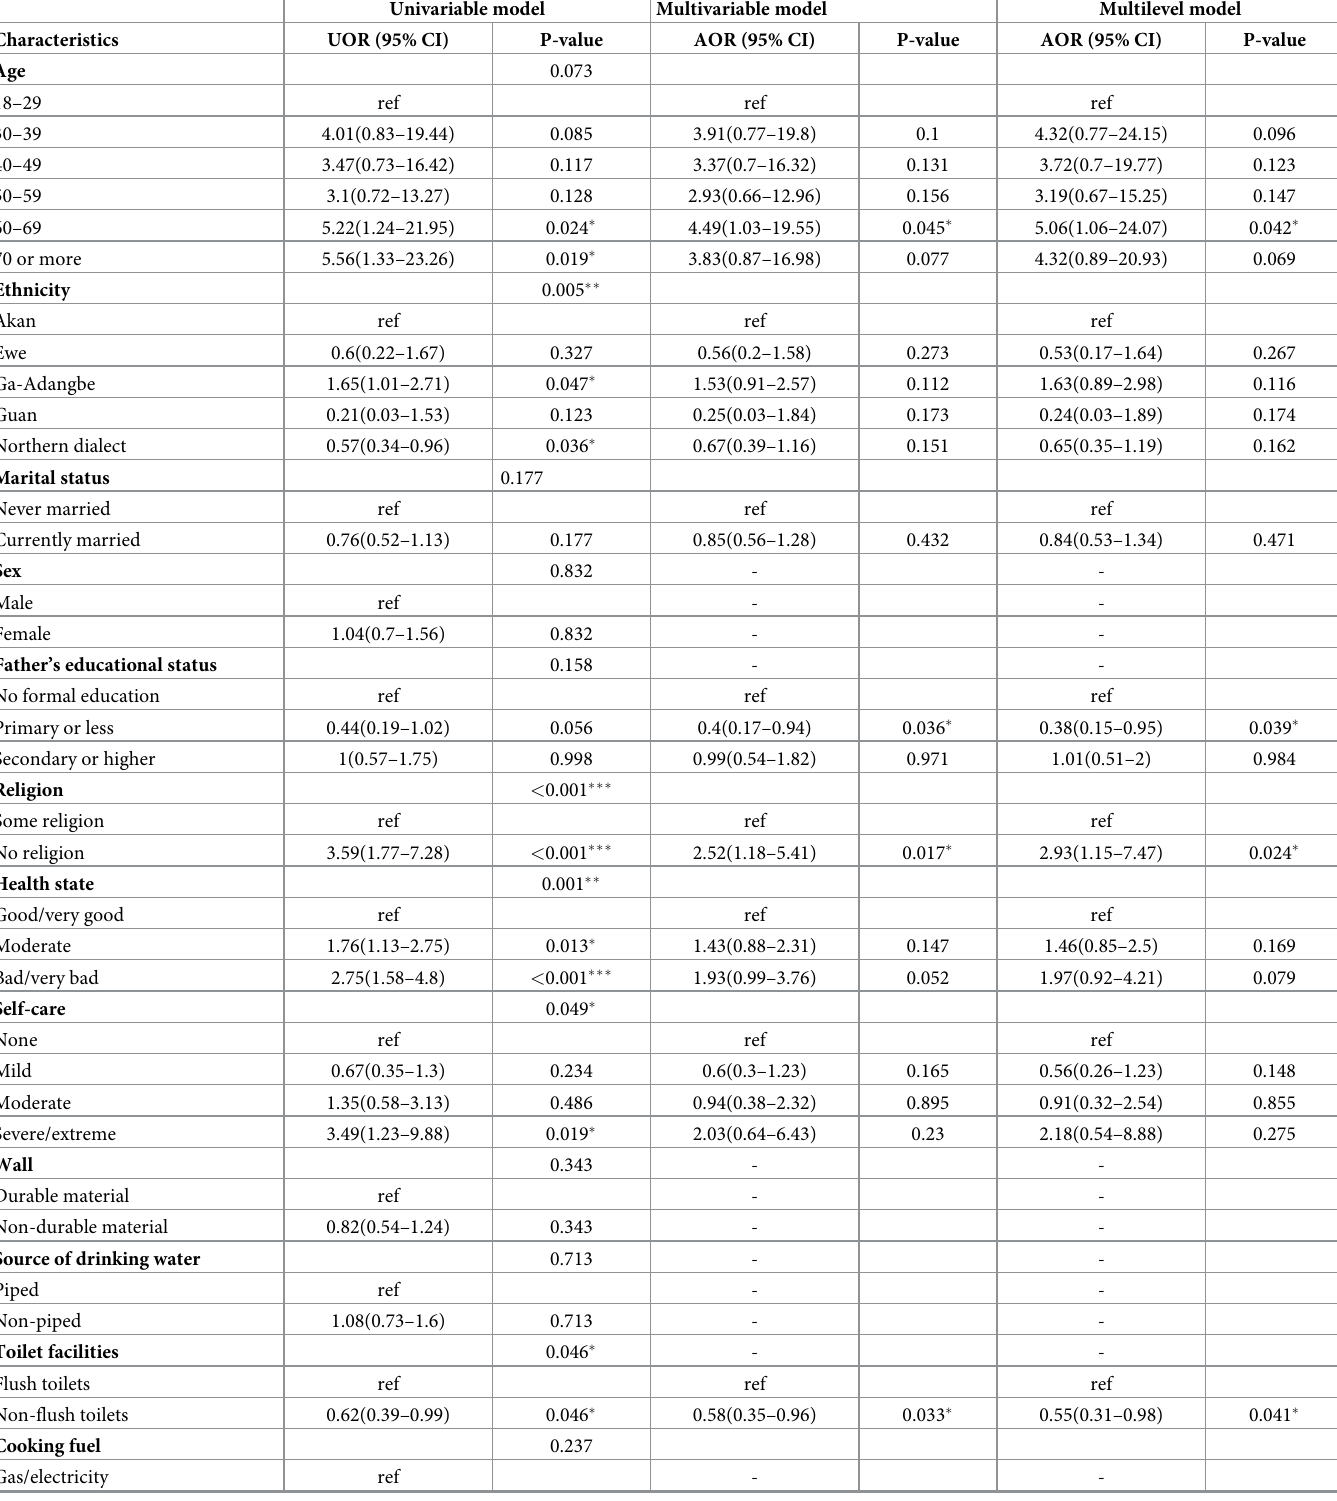
Table 2. Odds ratio for asthma: Single-level and multilevel binary logistic regression